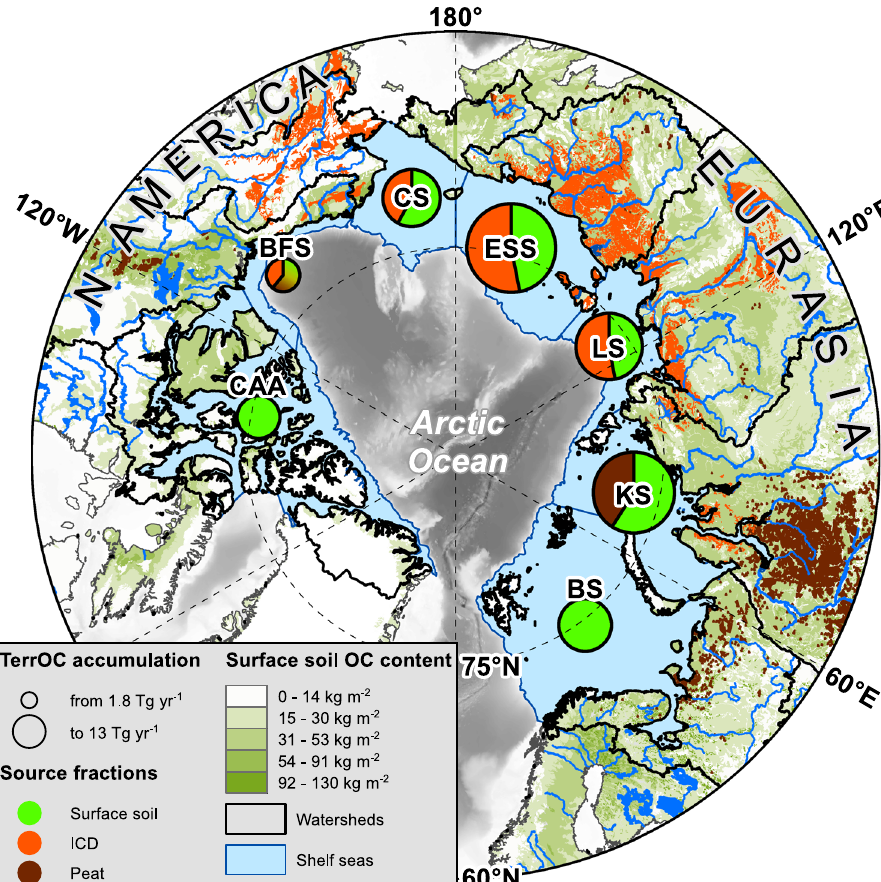
Fig. 1 | Overview ofthe different terrestrial organic carbon (terrOC) sourcesto circum-Arctic shelf sediments. The terrOC sources include surface soil (SurfSoil- OC; green colors), Ice Complex Deposits (ICD-OC; orange colors) and peat (brown colors), while petrogenic OC is excluded from terrOC. The size of the pie charts is proportional to the relative contributions of the different sources to the terrOC accumulatingintherecipientshelfsediments,(rangingfrom1.8Tgyr − 1 intheBFSto 13Tgyr − 1 in the ESS). Green shades on land indicate surface soil OC